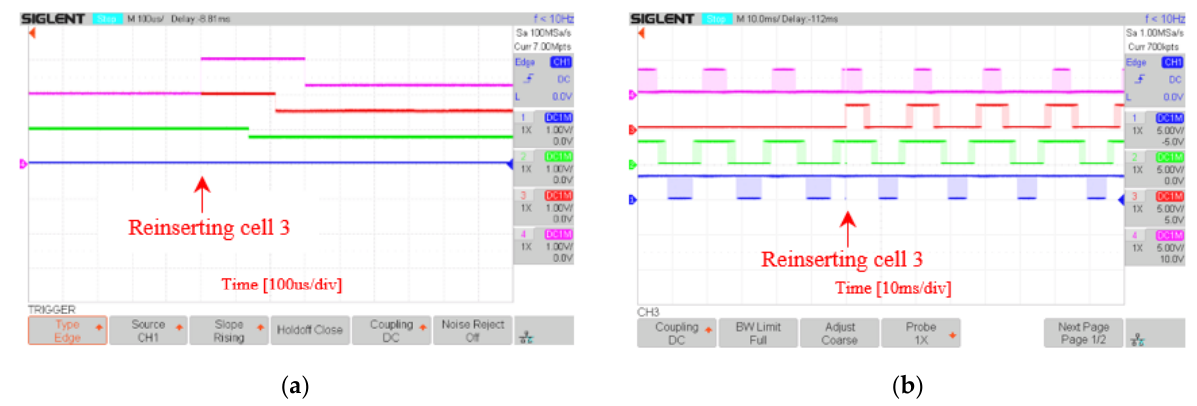
Figure 41. The system response of restructuring when reinserting cell 3 by using DSA-LSC method, ( a ) carrier levels; ( b ) PWM control signals.